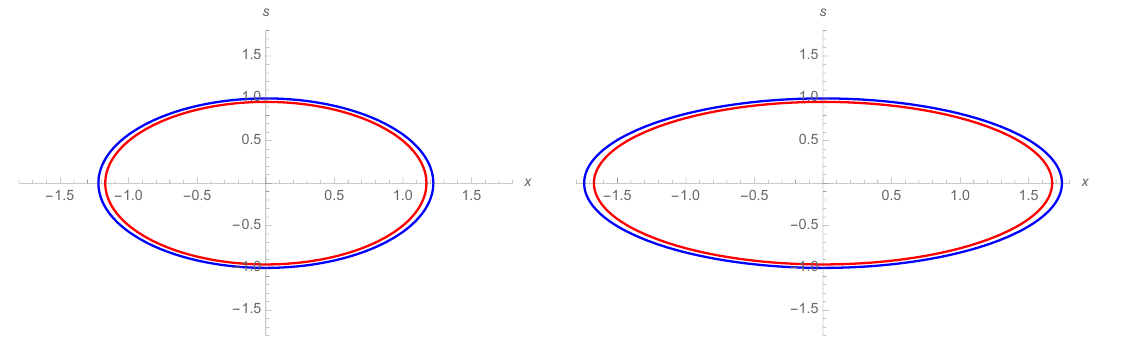
Figure 3 . The inner red surface corresponds to the solution for the charged membrane with (cid:11) = 0 : 2 and (cid:7) = 0 : 47 for the (cid:0) branch while the outer blue surface is for the uncharged